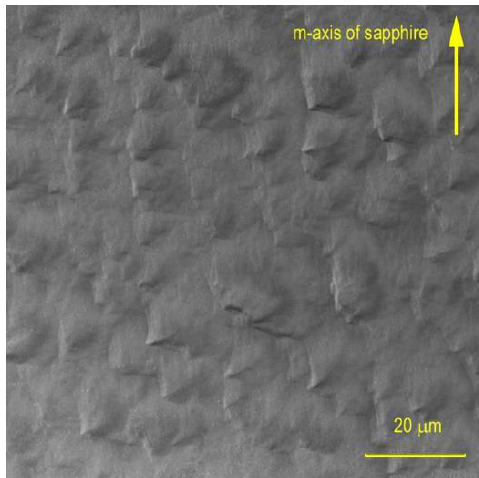
Figure 11. Laser microscopic image of p-GaN surface. The thickness of the p-GaN layer is 0.5 µm. The roughness (Ra) is 5.86. The p-GaN surface was obtained by erasing the hexagonal pyramids via three-dimensional growth. (Permitted to be reproduced from Jpn. J. Appl. Phys. [13]. © Japan Society Applied Physics).